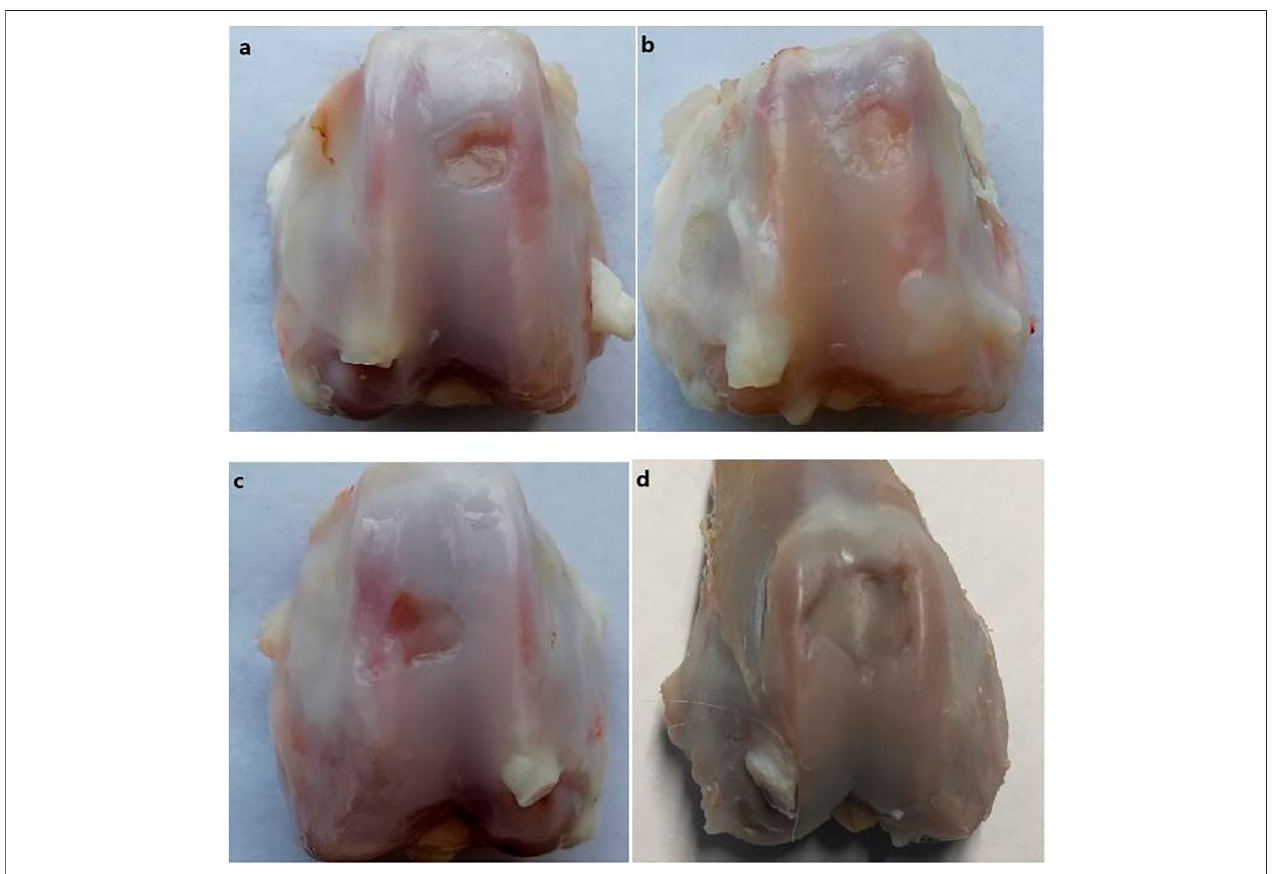
FIGURE 7 | Gross views of four groups of specimens taken at 6 weeks after